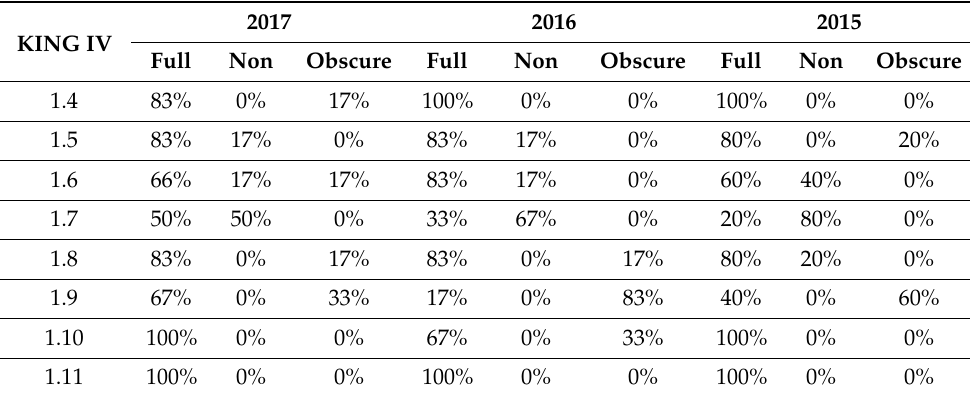
Table 3. Risk management practices disclosures.